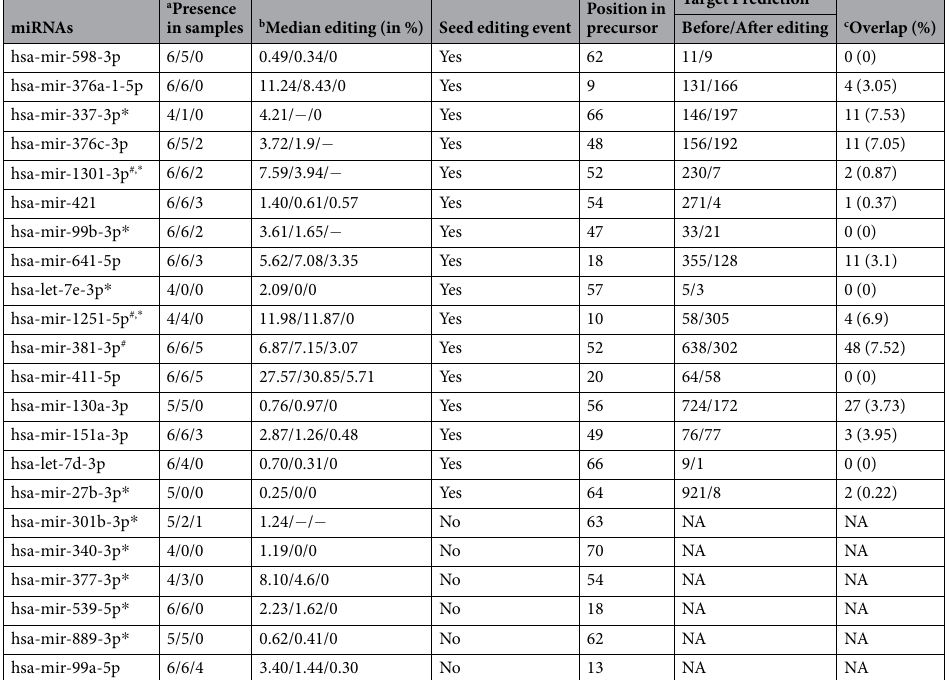
Table 1. A-to-I hypoedited miRNAs in Glioblastoma Multiforme (GBM). 22 miRNAs were found to be significantly hypoedited in GBM (wilcoxon-two-tailed, p < 0.05). a Presence in samples (FC/CC/GBM). b Median editing (FC/CC/GBM). c Percentage overlap was calculated by overlapped targets/targets before editing. NA, not applicable because they were not seed editing events. “ − ” Indicates miRNAs where median value could not be calculated. The asterisk ( * ) represents 11 novel miRNAs found to be hypoedited in GBM in this study. “#” Indicates events validated by SNPShot (data in Fig. 7A and Supplemental Figure